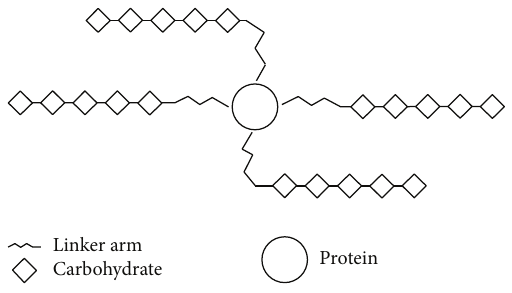
Figure 4: Single ended model (neoglycoprotein).